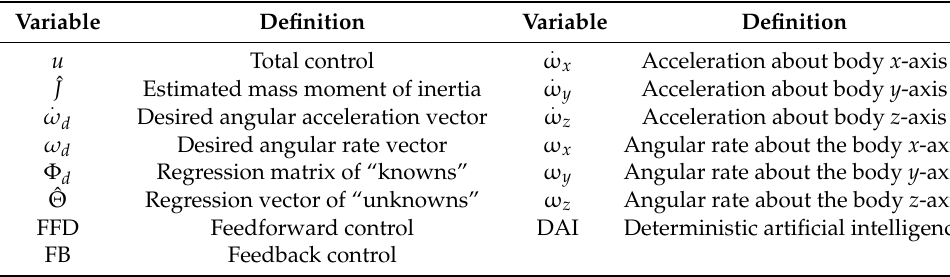
Table 4. Definitions of proximal variables for Section